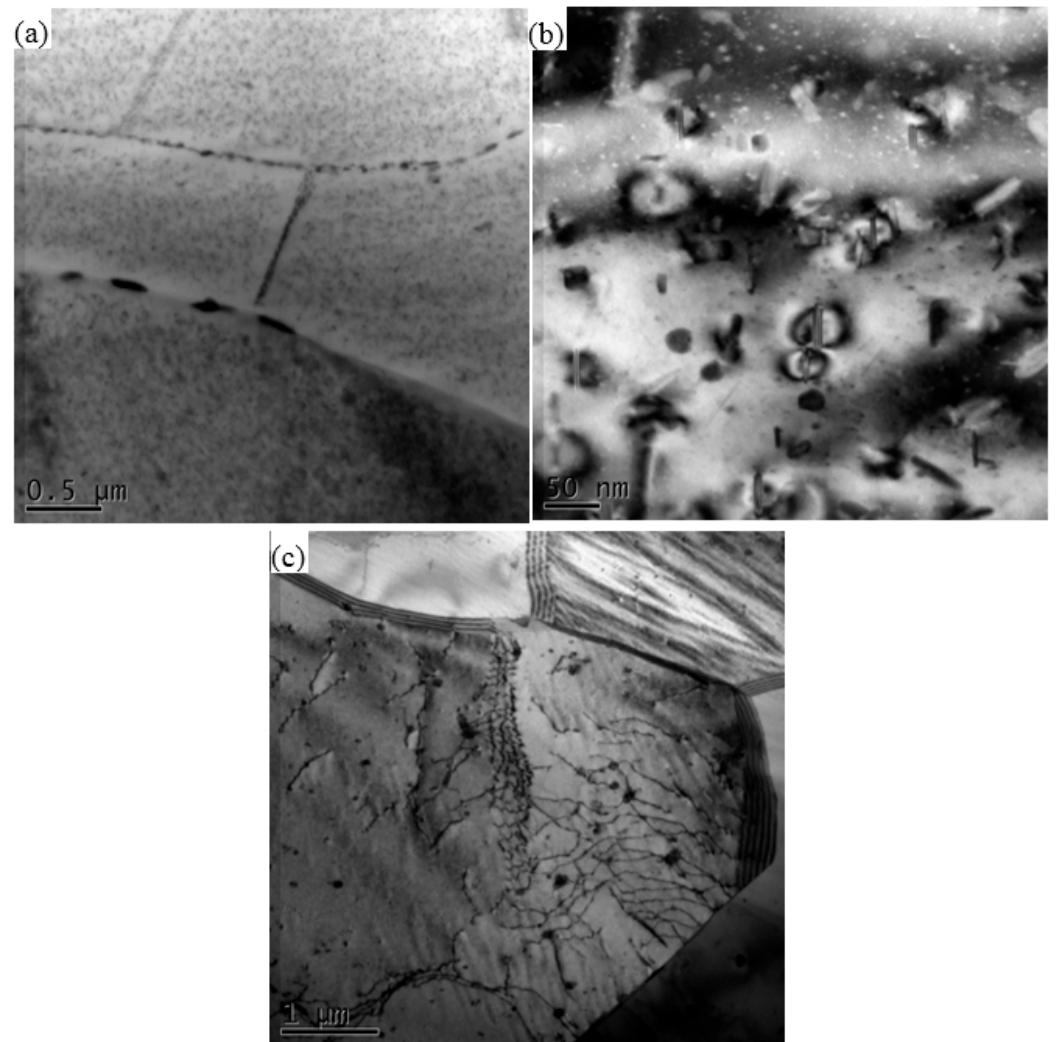
Figure 7. TEM of ( a ) heat-affecting-zone (HAZ); ( b ) magnification of ( a , c ) thermo-mechanical affected zone (TMAZ) in advancing side (AS).